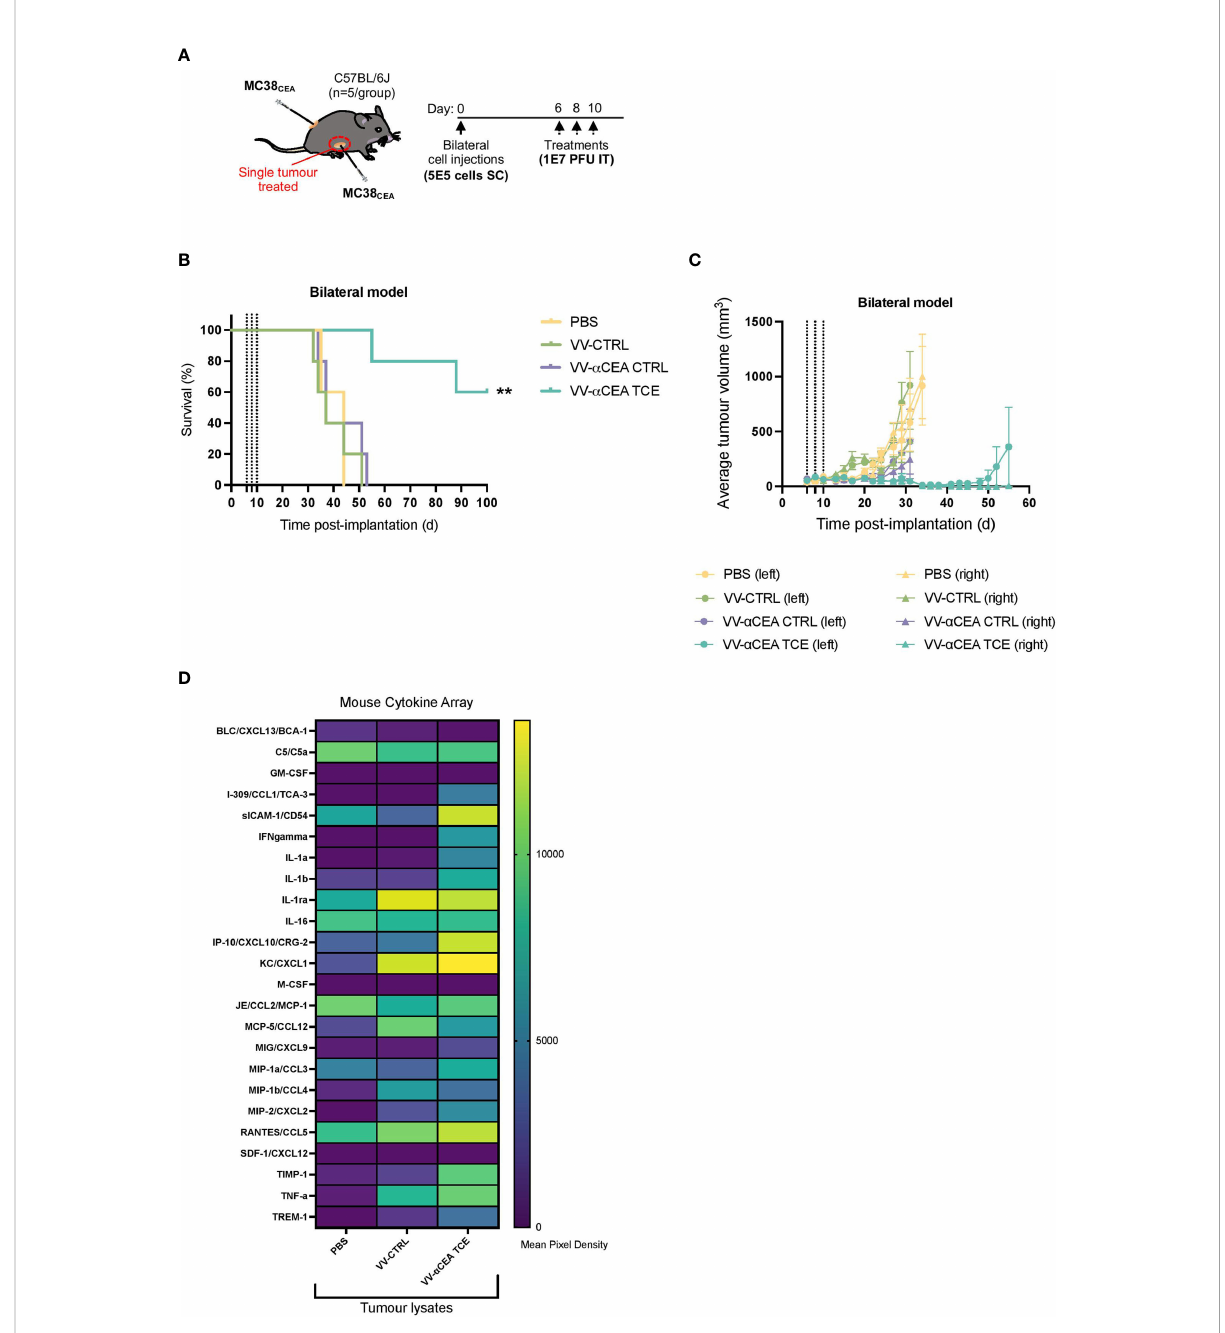
FIGURE 5 VV encoding TCE leads to abscopal effects and different cytokine pro fi les in tumours. (A) C57BL/6J mice bearing subcutaneous MC38 CEA bilateral tumours were injected unilaterally and intratumourally with 3 doses of viruses at 1E7 pfu, or PBS as control, at days 6, 8 and 10. (B) Mice treated with VV- a CEA TCE (CEA:mCD3) showed increased survival, and 60% of these mice were cured after unilateral treatment, compared to groups treated with PBS, VV-CTRL or VV- a CEA CTRL (CEA:hCD3). (C) Mice treated with VV- a CEA TCE (CEA:mCD3) showed regression of both simultaneously engrafted tumours, compared to groups treated with PBS, VV-CTRL or VV- a CEA CTRL (CEA:hCD3). (D) We performed a murine cytokine assay using tumour lysates from subcutaneous MC38 CEA tumours in mice treated with VV- a CEA TCE, VV-CTRL or PBS. Of note, differential expression of cytokines was most evident in tumour samples. We detected more abundant levels of sICAM-1, CXCL10, CXCL1, CCL5, TIMP-1 and TNF a in tumours treated with VV- a CEA TCE, compared to tumours treated with VV-CTRL or PBS. We also identi fi ed unique signatures after VV- a CEA TCE treatment, including increased levels of CCL1, IFN g , IL-1a, IL-1b, TIMP-1, and